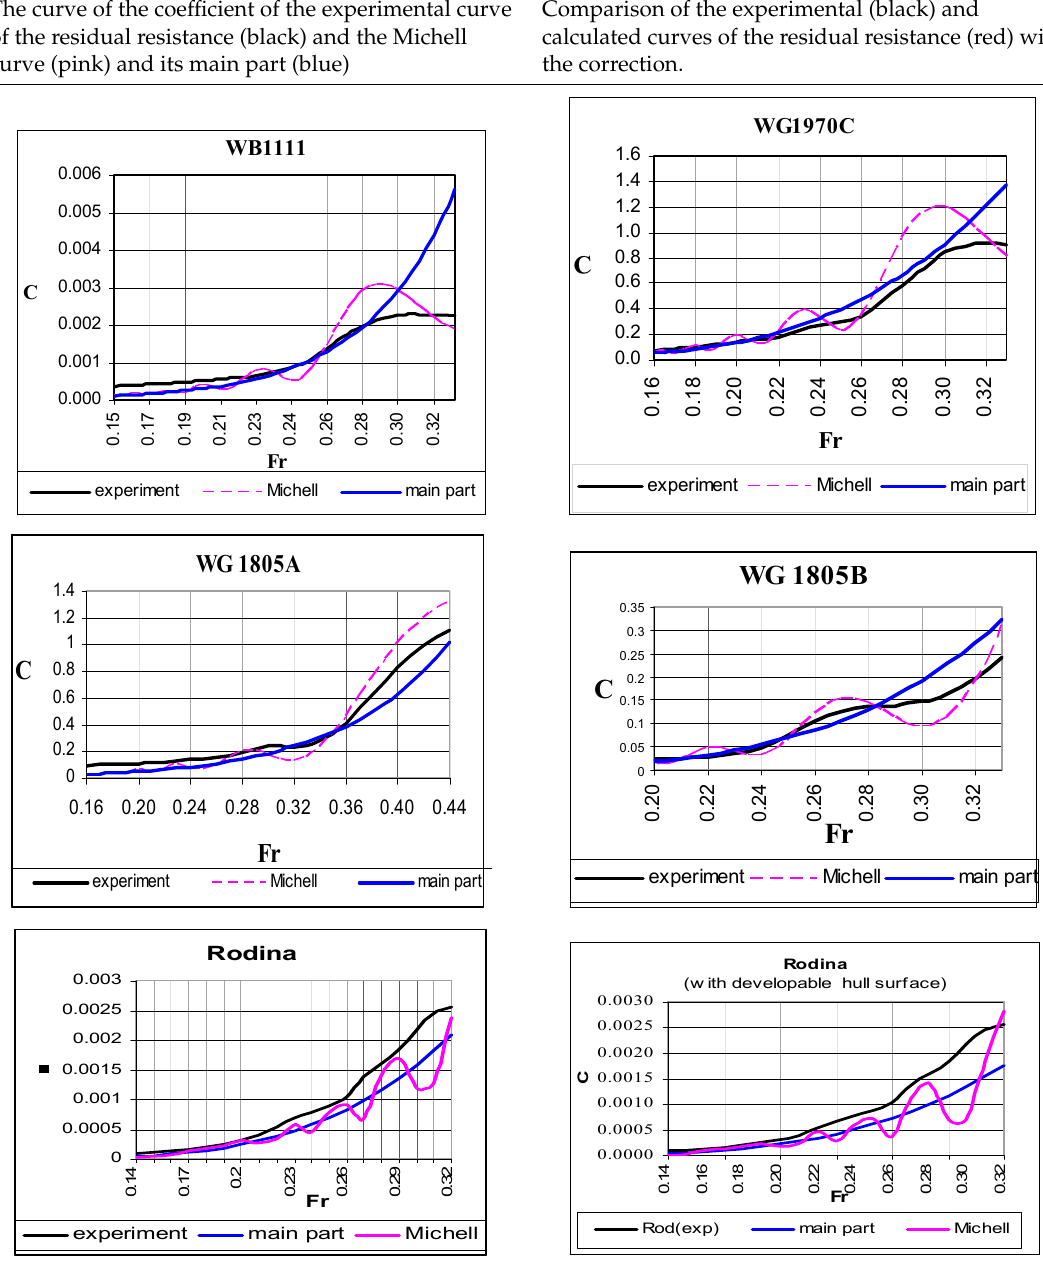
Table 7. Cont. Comparison of the experimental (black) and calculated curves of the residual resistance (red) with the correction.